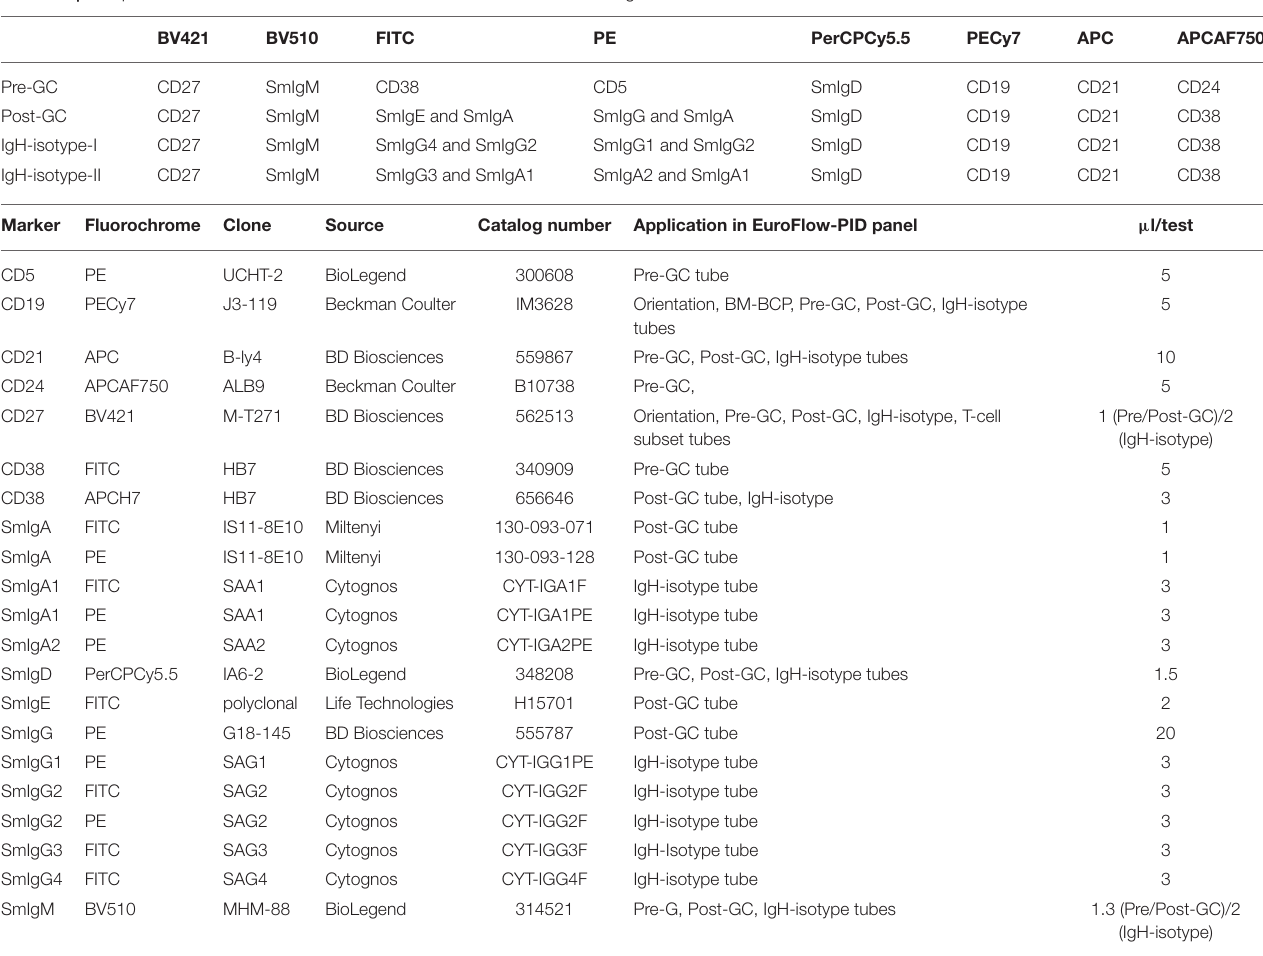
TABLE 2 | Composition of the 8-color B-cell tubes and technical information on